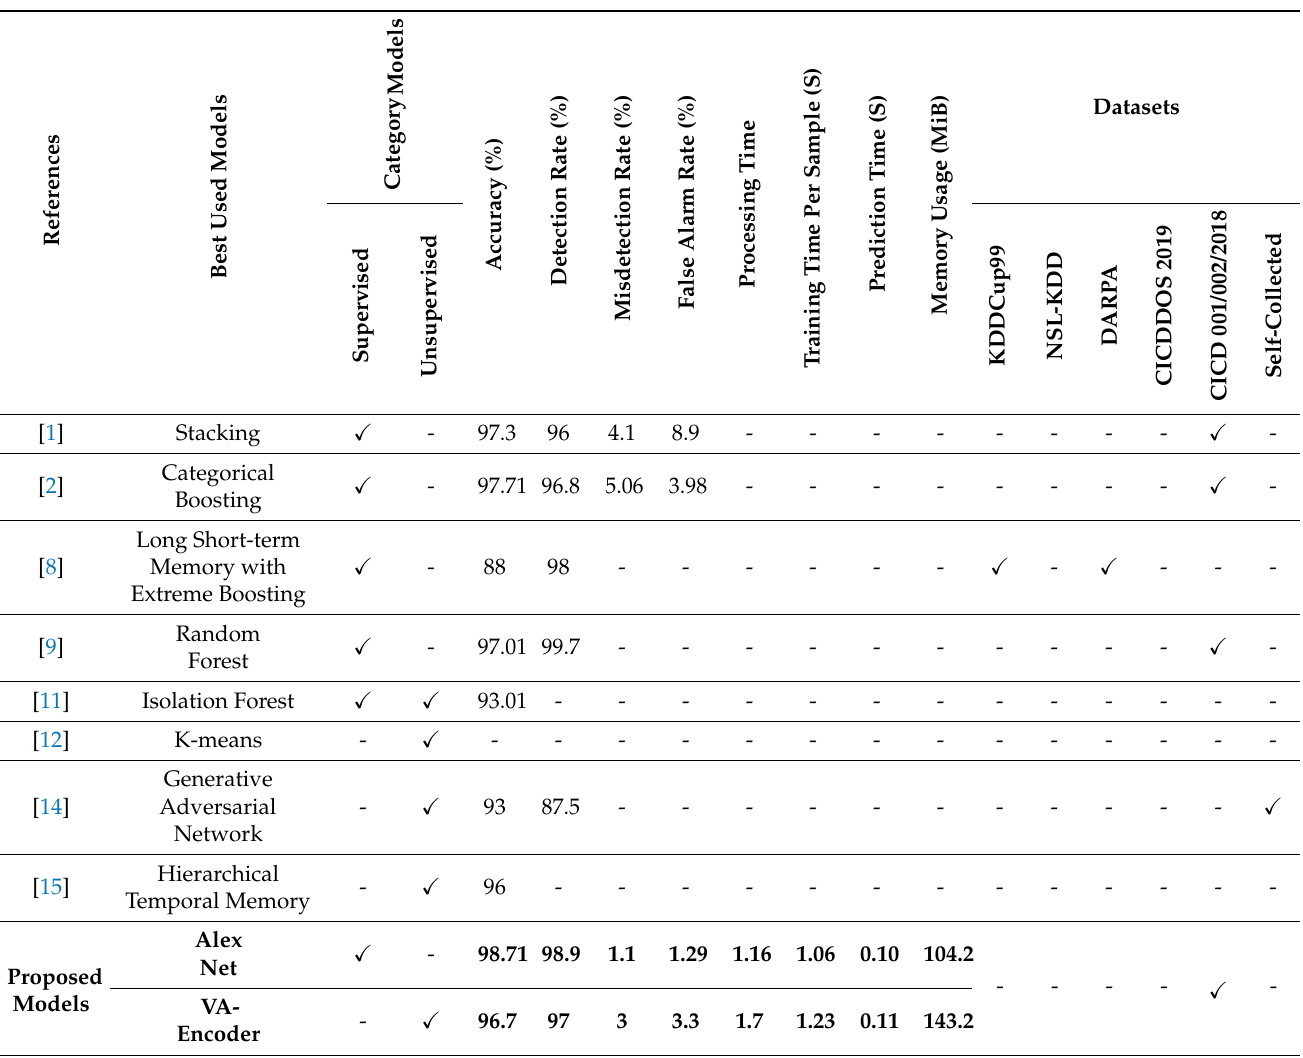
Table 6. Comparison of related works with the proposed